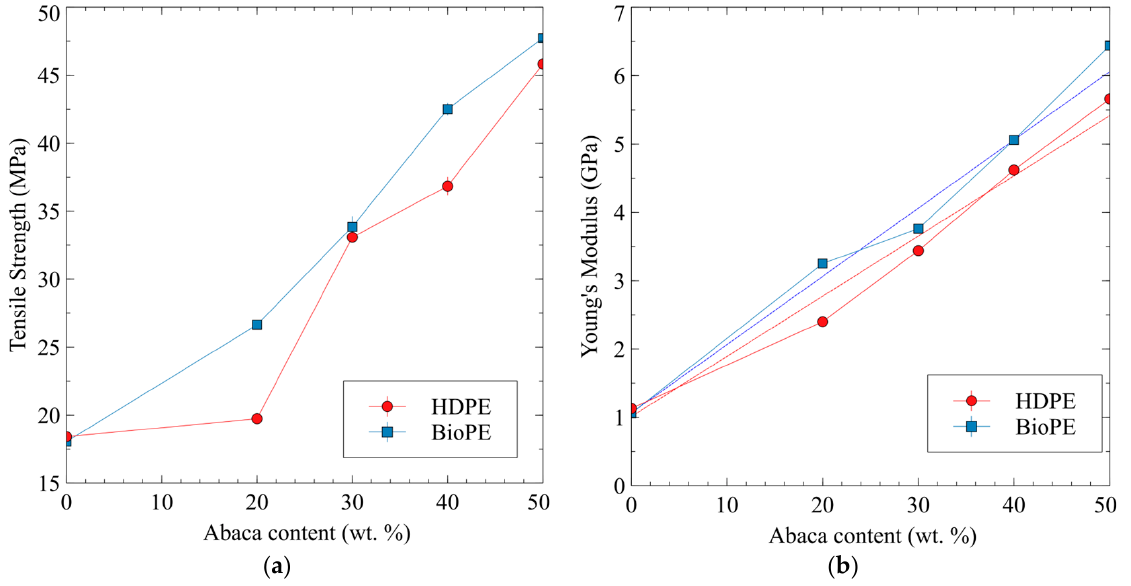
Figure 1. Evolution of the tensile properties of AF-reinforced HDPE and BioPE composites against abaca fiber contents; ( a ) tensile strength; ( b ) Young’s modulus.